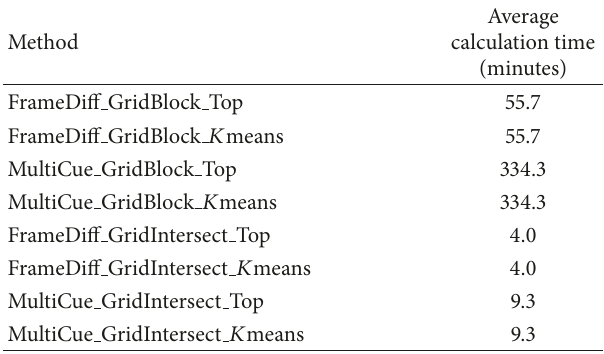
Table 9: Average calculation time of all methods for a test surgical workflow (12.8 minutes of